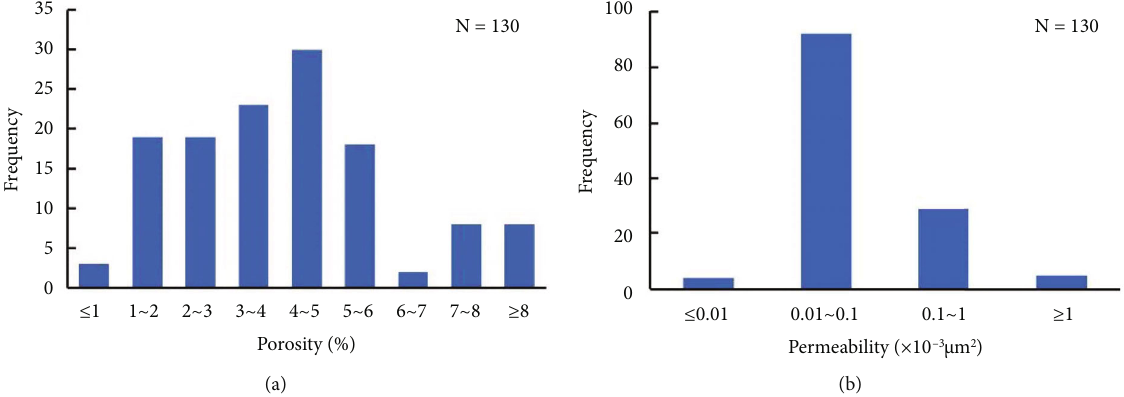
Figure 2: Distribution histograms of porosity (a) and permeability (b) of clastic reservoirs in Yingcheng Formation in the study area.